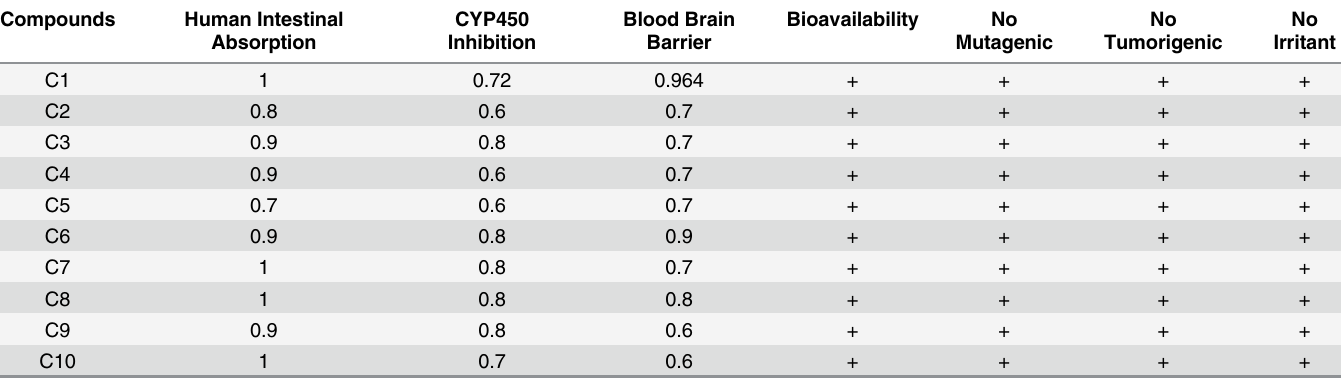
Table 3. ADME and Toxicity Analysis.